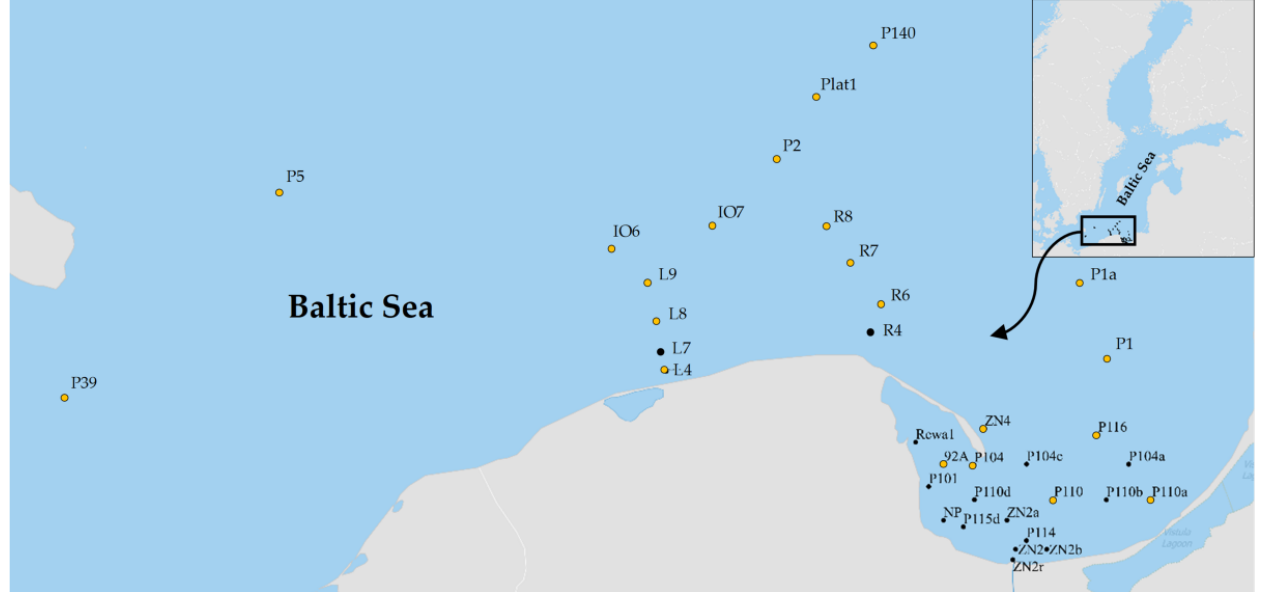
Figure 2. Location of sampling stations in May 2018 in the southern Baltic Sea (large concentrations of pollen grains were indicated by yellow).